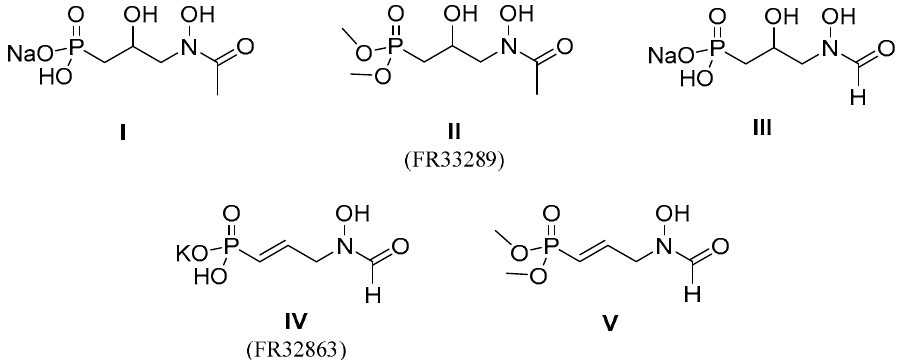
Figure 2. Additional phosphono-hydroxamic acids published by the Fujisawa Pharmaceutical Co., Ltd.